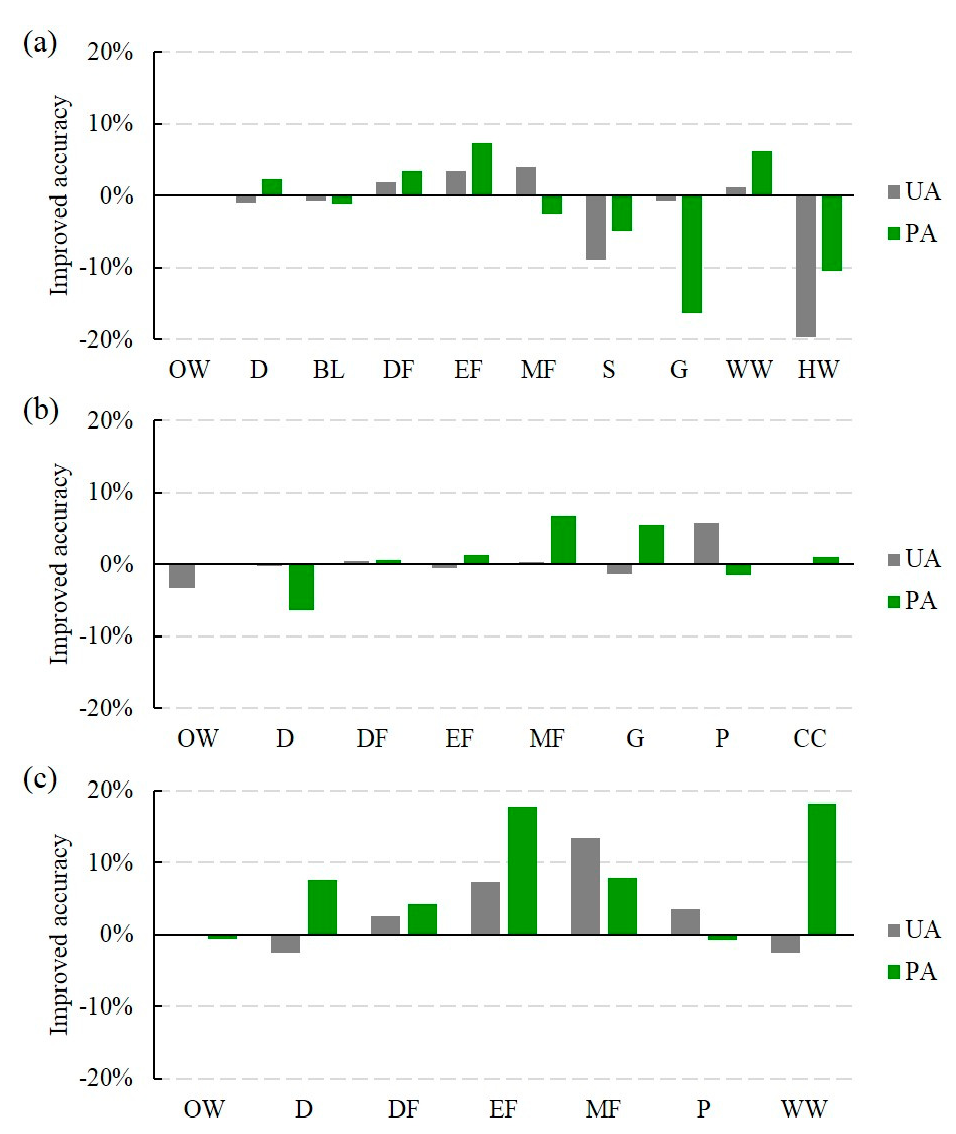
Figure 7. The differences in PA and UA between the TSM-adjusted and original percentiles-based classification for individual land-cover types in Minnesota ( a ), Iowa ( b ), and New York ( c ).